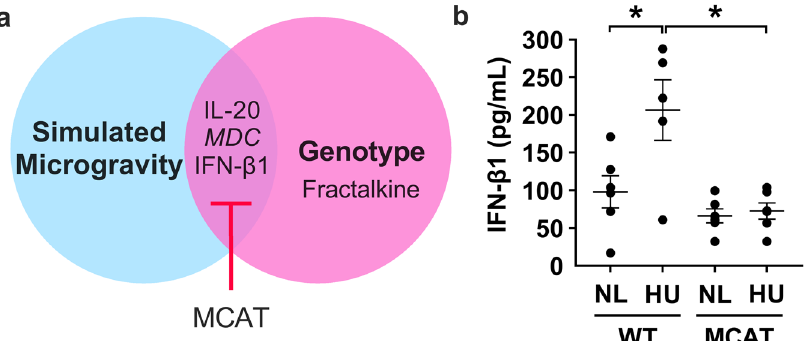
Fig. 5 Effects of combined isolation and simulated microgravity and the impact of MCAT genotype on plasma cytokine expression (single housed groups only). a Diagram showing the effect of simulated microgravity and genotype on plasma cytokine expression in single housed animals. Three cytokines were differentially expressed in plasma of single housed HU versus NL mice and mitigated in MCAT HU mice. MDC was downregulated (italics) while IL-20 and IFN- β 1 were upregulated. b Representative graph showing IFN- β 1, one of the two cytokines elevated by HU and mitigated in MCAT mice. NL WT ( n = 6), HU WT ( n = 5), NL MCAT ( n = 6), and U MCAT ( n = 6). Some data points overlap. *Statistically signi fi cant at p < 0.05 by two-way ANOVA and Tukey post hoc